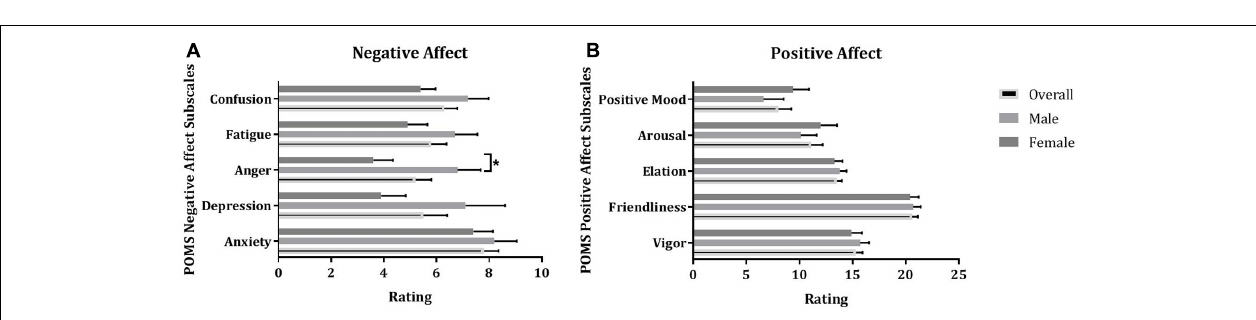
FIGURE 4 | Mean ( ± SE) of ratings of males, females, and both groups together (overall) on Negative (A) and Positive (B) Affect scales of the Profile of Moods States; ∗ indicates statistical significance at p = 0.05.